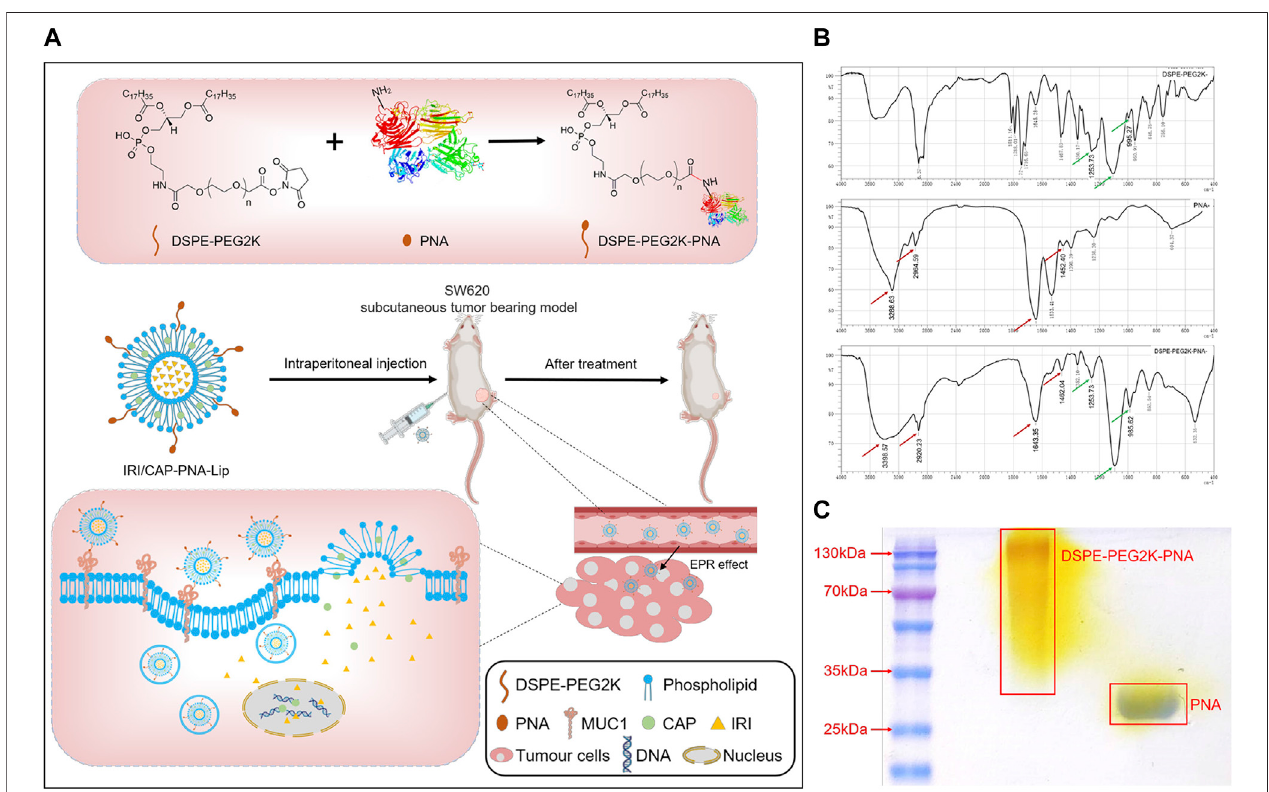
FIGURE 1 | (A) Schematic diagram of the preparation of PNA-modi fi ed liposomes and ligand – receptor-mediated targeting mechanisms for tumor tissue recognition. Liposomes loaded with IRICAP were modi fi ed with PNA as the ligand. PNA speci fi cally interacts with MUC1, which is highly expressed in colorectal cancer cells.IRIandCAParereleasedintocellsandbindtoDNAtoinhibitnucleicacidsynthesis,thusenhancingtheef fi cacyofanti-colorectalcancer. (B) Infraredspectroscopy identi fi ed the successful synthesis of DSPE-PEG2K-PNA. (C) SDS – PAGE to identify PNA was ligated to